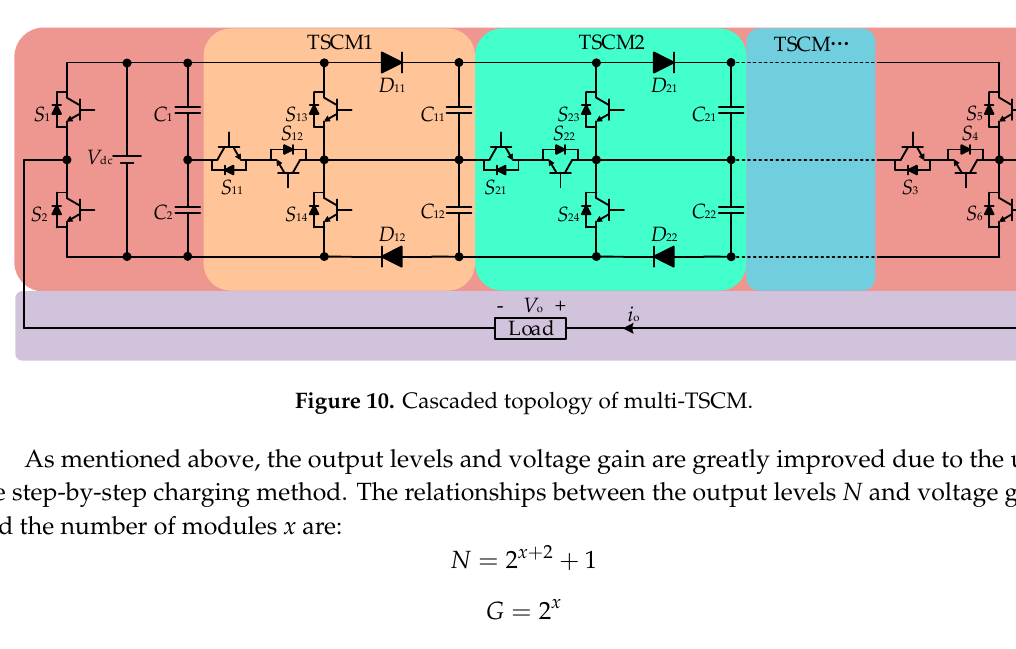
Table 4. Working state of devices in the 17-level inverter.